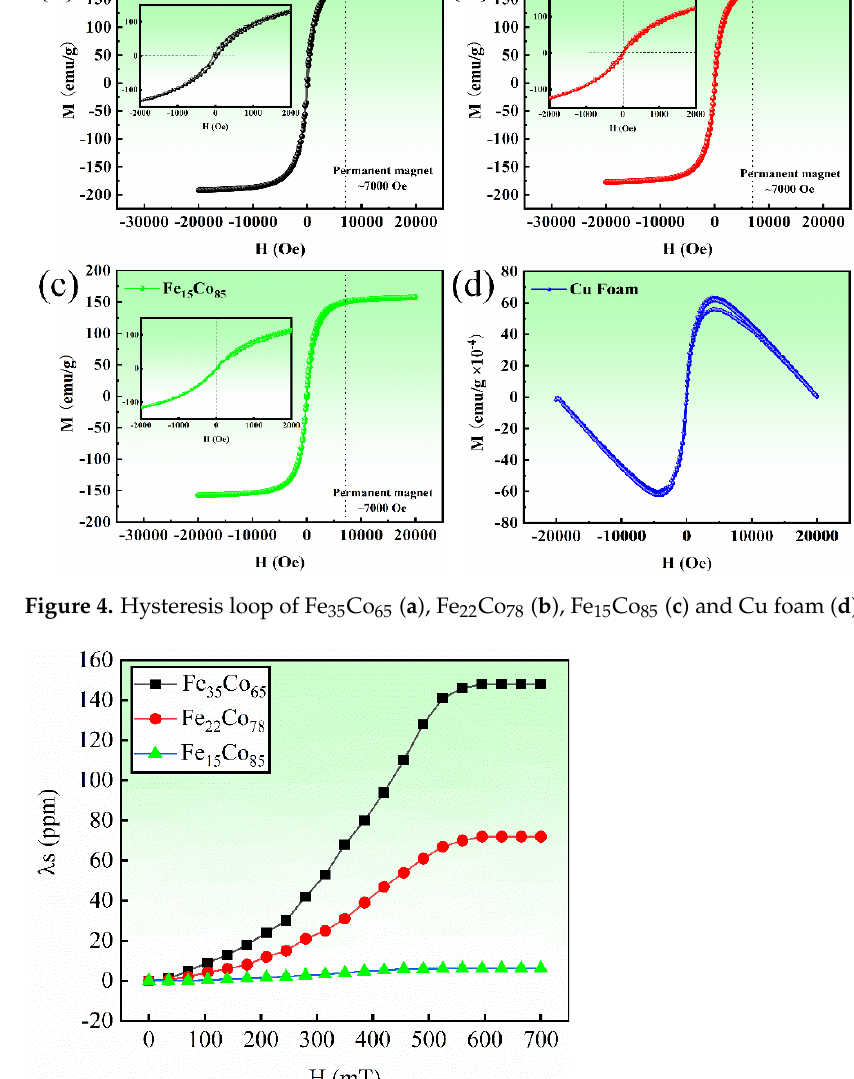
35 Co 65 , Fe 22 Co 78 , Fe 15 Co 85